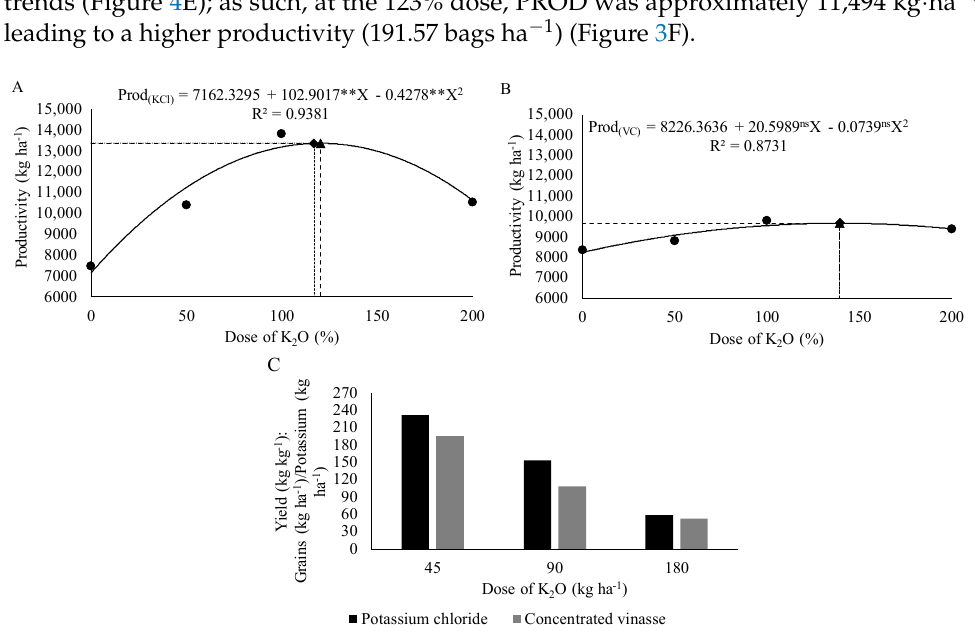
Figure 5. Comparison of produced yield between concentrated vinasse and potassium chloride ( A ) and the agronomic efficiency index of concentrated vinasse ( B ).